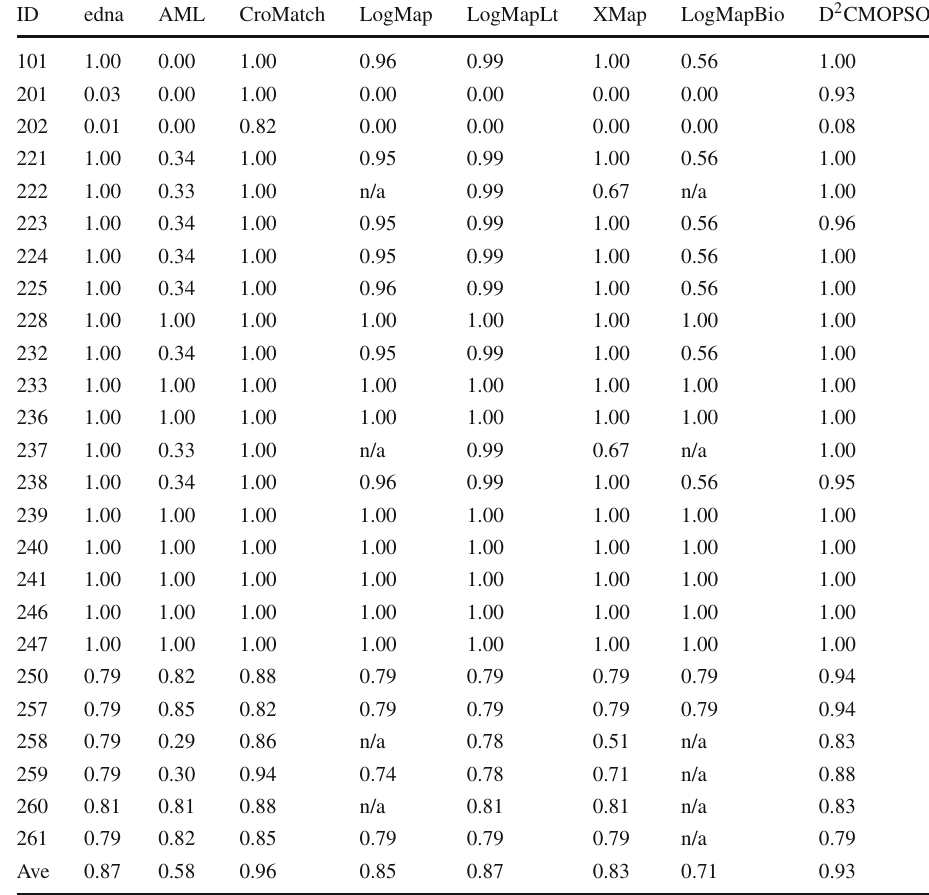
Table 15 Comparison on OAEI’s participants and D 2 CMOPSO in terms of